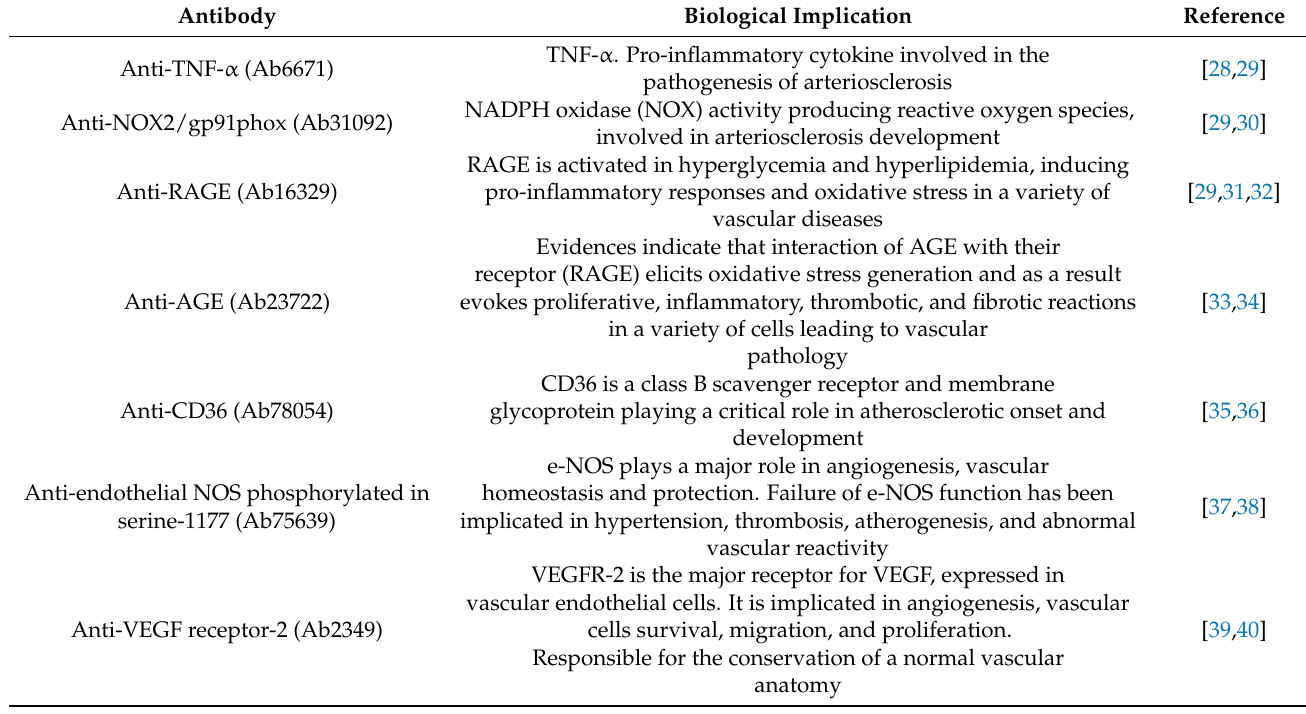
Table 1. Immunohistochemistry using vascular biology relevant markers. Antibody Biological Implication